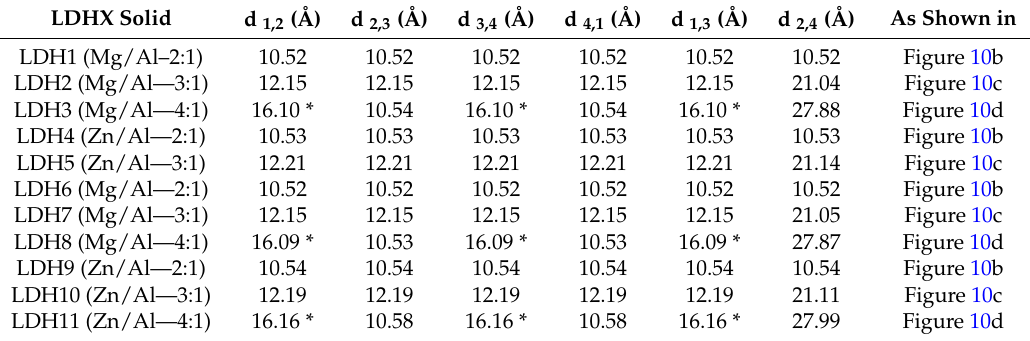
* Distances coincident with the found value for the distance between the negative charges of MnP.